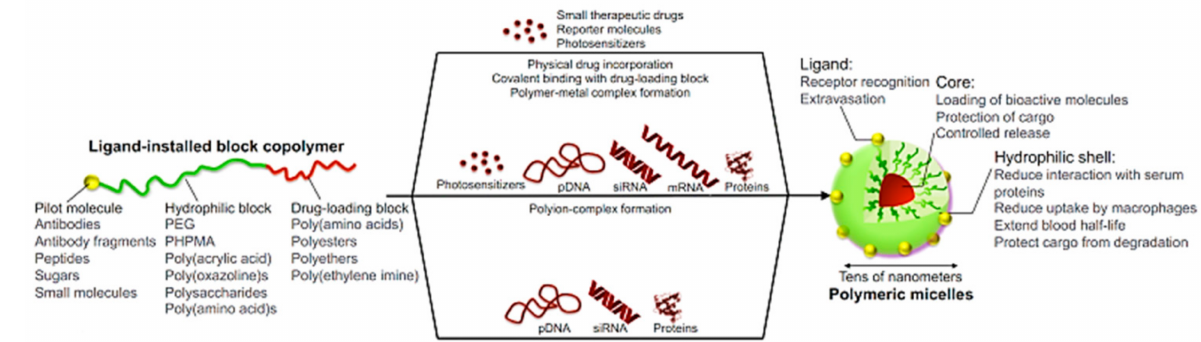
Scheme 4. Self-assembled formation of polymeric micelle utilizing ligand-installed block copolymer for encapsulation of therapeutics. Reprinted with permission from Ref. [42]. Copyright 2018,